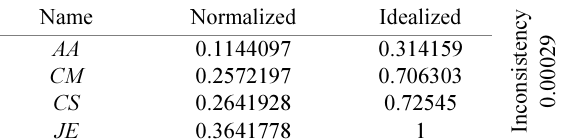
Table 6. Weight vectors